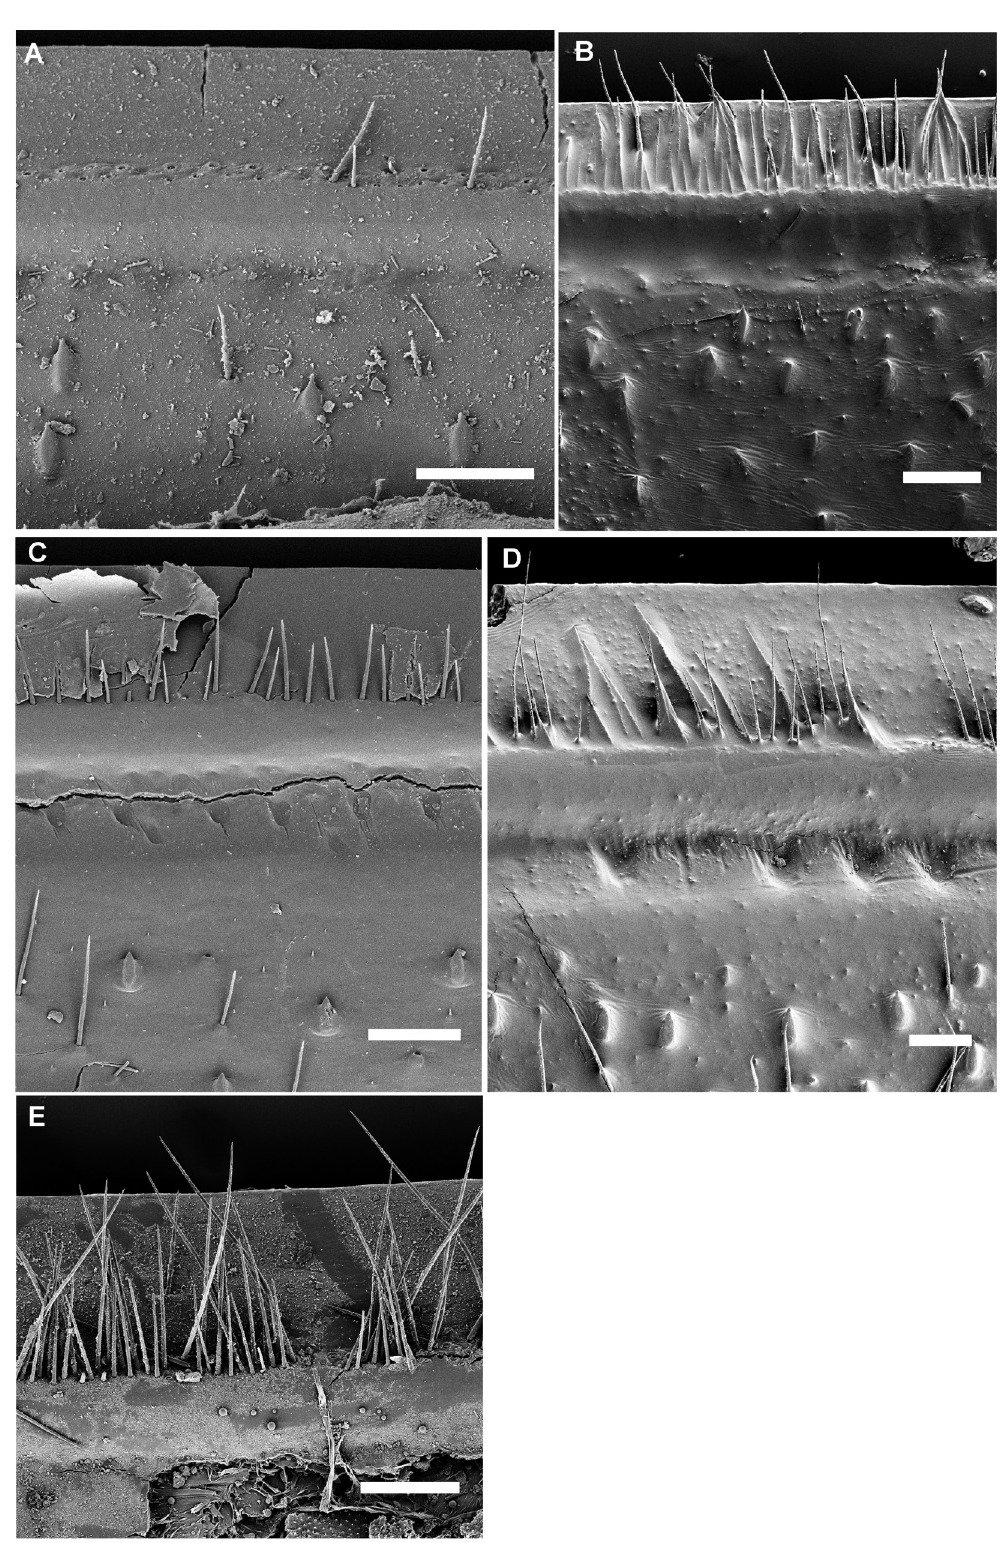
Fig. 5. Scanning electron micrographs of the endoterga of midbody rings. A . Zoosphaerium nigrum sp. nov., holotype (CASENT 9068289). B . Z. silens sp. nov., holotype (FMNH-INS 3119887). C . Z. ambatovaky sp. nov., holotype (CASENT 9068294/1). D . Z. beanka sp. nov., holotype (FMNH- INS 3119897). E . Z. voahangy sp. nov., holotype (FMNH-INS 3119921). Scale bars = 100